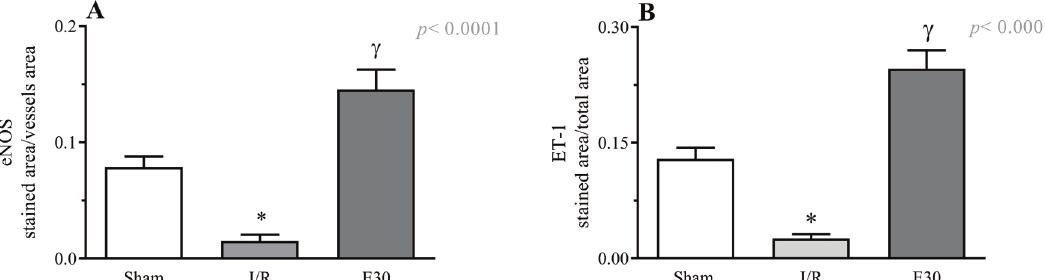
Figure 3 - Quantification of eNOS (panel A) and endothelin-1 (panel B) expression in mesenteric vessels. In rats with I/R injury, the superior mesenteric artery was clamped (45 min), followed by intestinal reperfusion (2h). Estradiol (180 m g/kg, i.v.) was administered 30 min after induction of intestinal ischemia (E30). Sham-operated rats were used as control. Data are expressed as the mean ± standard error of the mean (SEM) from 4 animals/group (2 tissue sections/animal). Panel A: * p =0.0026 compared with the sham group; g p o 0.0001 compared to intestinal I/R. Panel B: * p o 0.0001 versus sham group; g p o 0.0001 versus intestinal I/R. eNOS, endothelial nitric oxide synthase; I/R, ischemia and reperfusion.